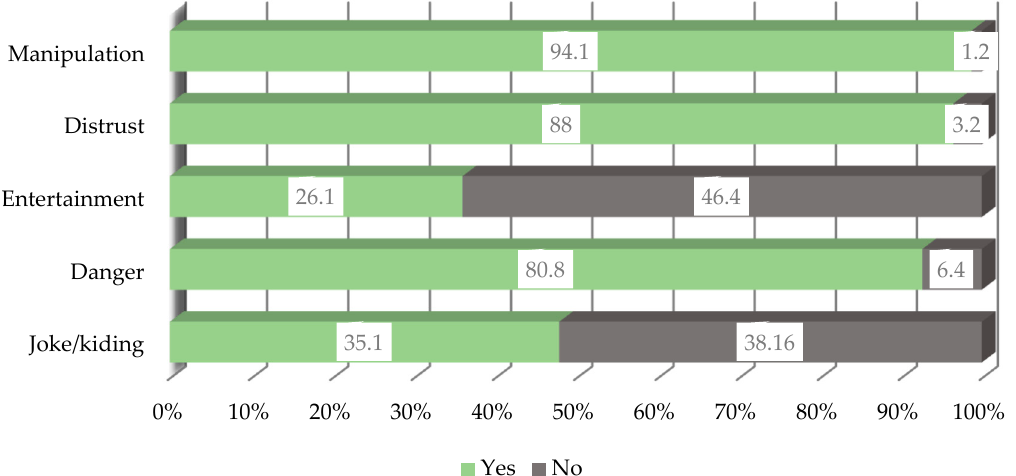
Figure 7. What feelings do you associate fake news with? Own elaboration.